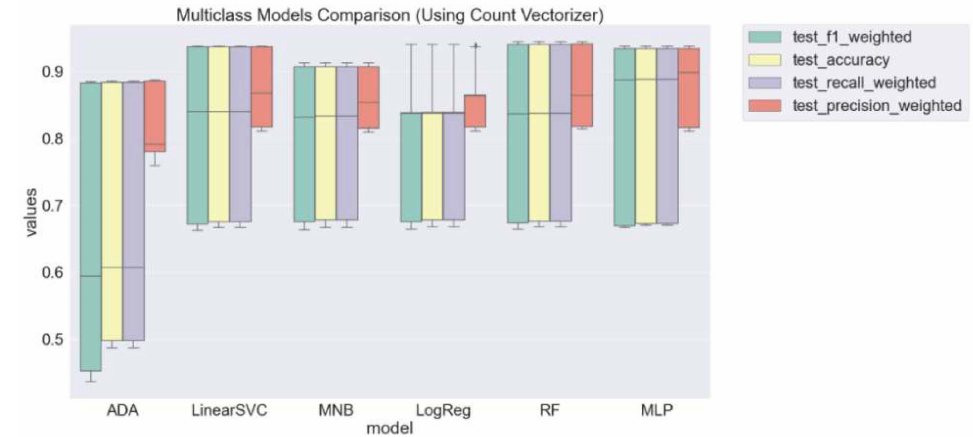
Figure 3. Overall weighted scores for each model trained and tested with count vectorizer.